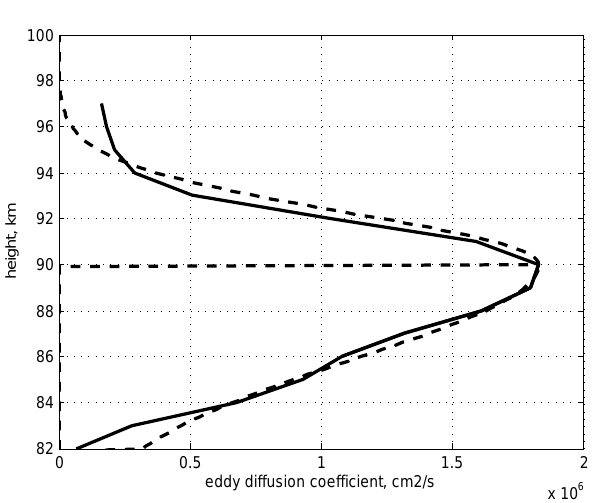
Figure A2. The height profiles of the energy dissipation rate measured by Lübken (1997) (dashed curve) and approximated by Eqs. (A1) and (A2) suggested by Shimazaki (1971) (solid curve) with ε m = 13.5Kday − 1 instead of K m and S 1 = 0.01km − 1 , ed S 2 = 0.06km − 2 , and S 3 = 0.1km 2